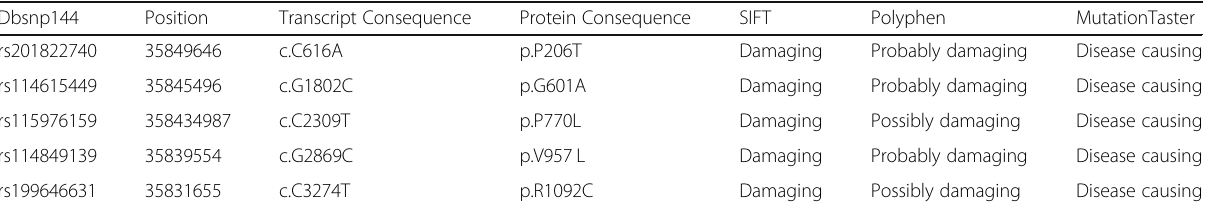
Three different software are used to predict the likelihood of causing disease: SIFT, Polyphen and